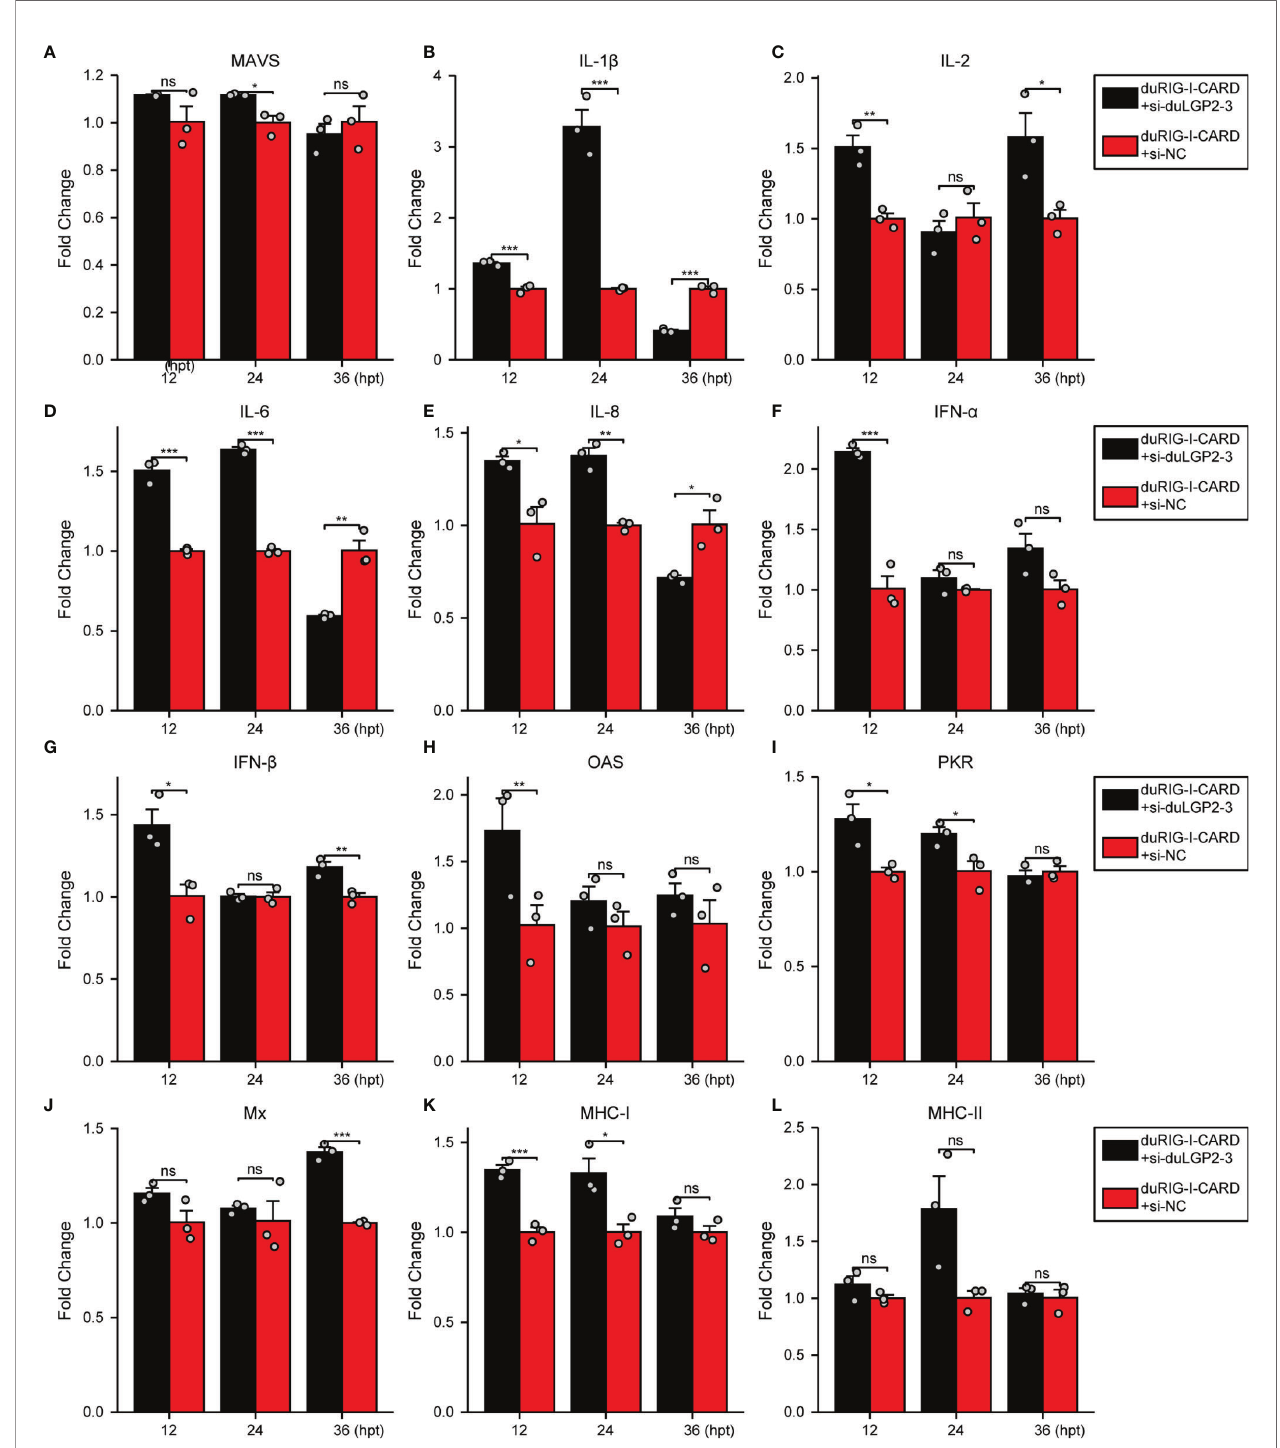
FIGURE 4 | Knockdown of duLGP2 regulates duRIG-I-mediated cytokines expression. DEF cells were transiently transfected with siduLGP2-3 or si-NC, and the cells were transfected with indicated plasmids or empty plasmids pCAGGS 24h after transfection with siRNAs. Cell samples were collected for analysis of cytokine detection at different time points. (A) MAVS (B) IL-1 b (C) IL-2 (D) IL-6 (E) IL-8 (F) IFN- a (G) IFN- b (H) OAS (I) PKR (J) Mx. (K) MHC-I (L) MHC-II. The relative expression of gene mRNA was calculated using the 2 − DD Ct method with GAPDH serving as a normalization gene and mean control values as a baseline reference, and the values in the control groups (pCAGGS co-transfection) were set to 1. All samples were analyzed in triplicate, and all data were expressed as means ± SEM. *Signi fi cant difference ( P < 0.05); **Highly signi fi cant difference ( P < 0.01); ***Extremely signi fi cant ( P < 0.001); ns, no signi fi cant